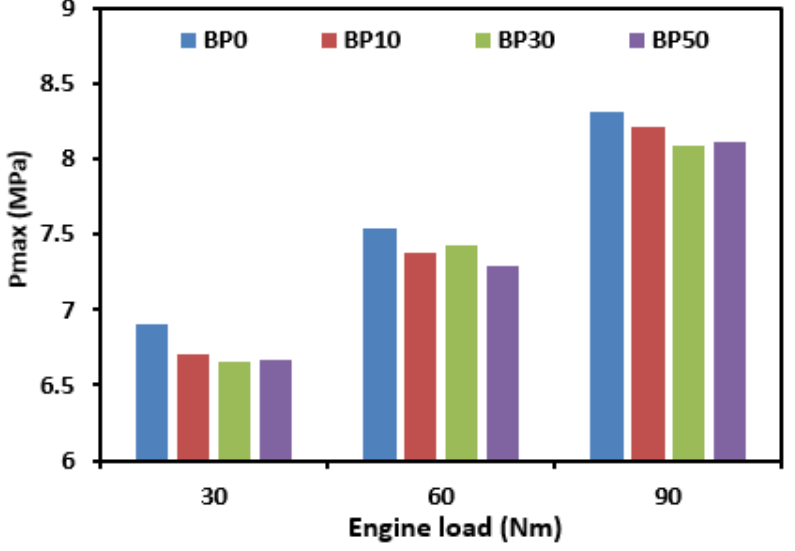
Figure 3. Maximum in-cylinder pressure for all test fuels according to various engine loads.